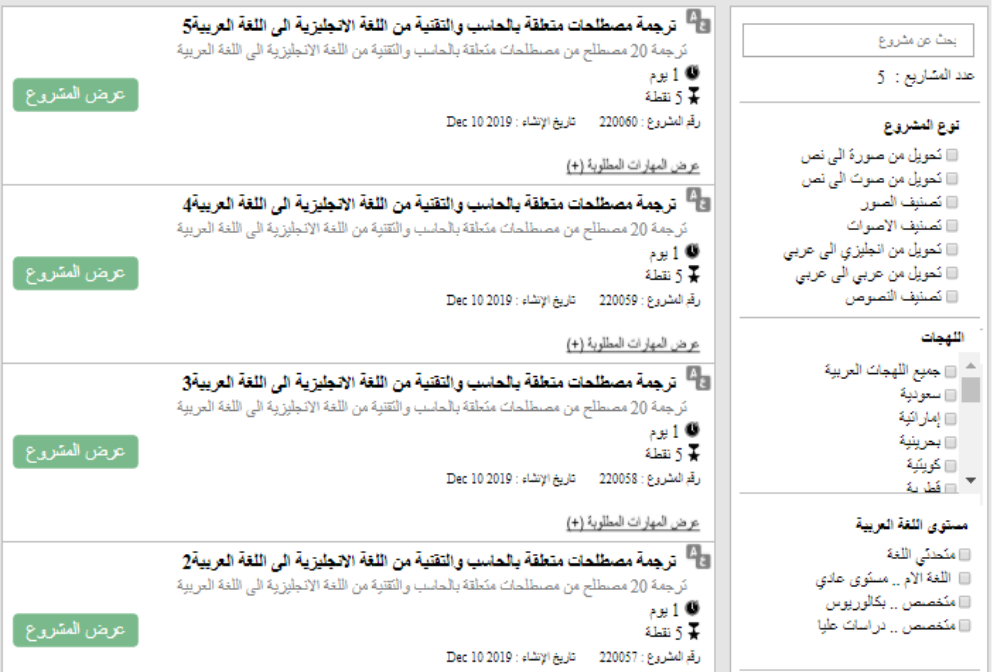
Figure 8. Open project for the participation page.